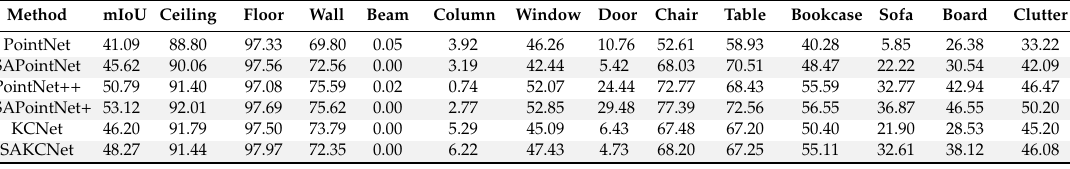
Table 2. Intersection over union (IoU) (%) of the segmentation results on Area 5 of the S3DIS dataset.